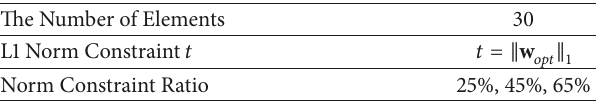
Table 3: Parameter values for sparsity simulations. The Number of Elements 30 L1 Norm Constraint 𝑡 𝑡 = ‖ w 𝑜𝑝𝑡 ‖ 1 Norm Constraint Ratio 25%, 45%,